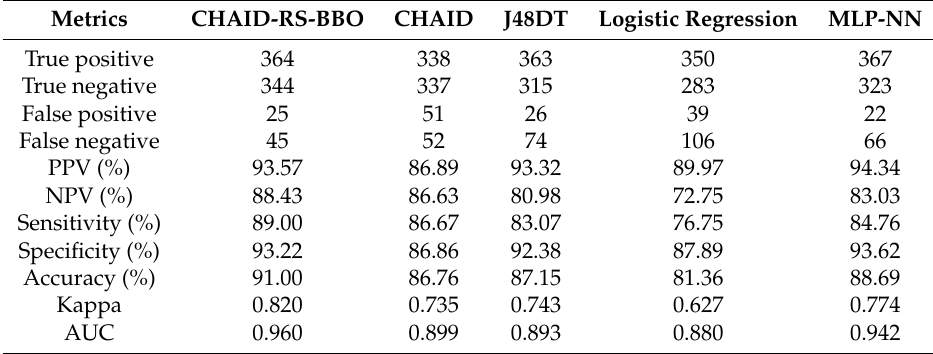
Table 4. Performance of the flash flood models in the validation phase.